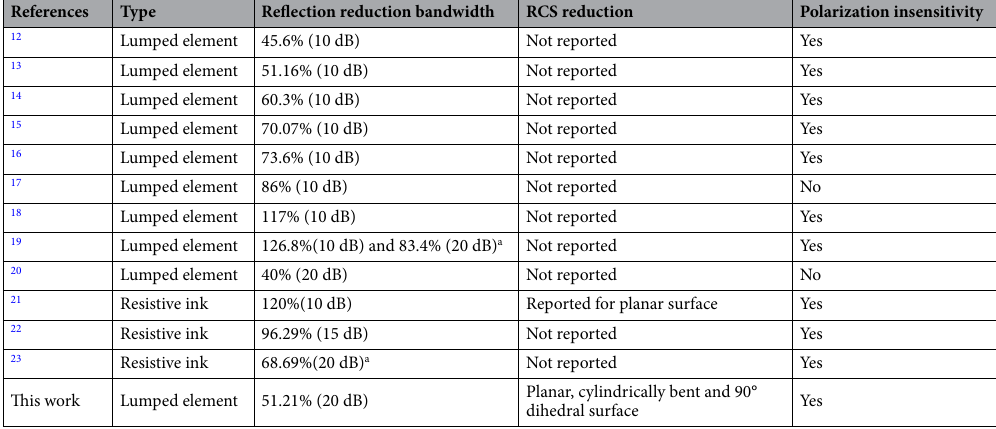
Table 1. Performance of developed device with previous reported work. a Measurement reported only for 10 dB reflection